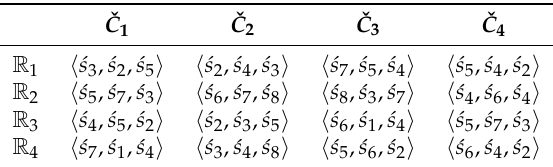
Table 1. R 1 (Decision-matrix).